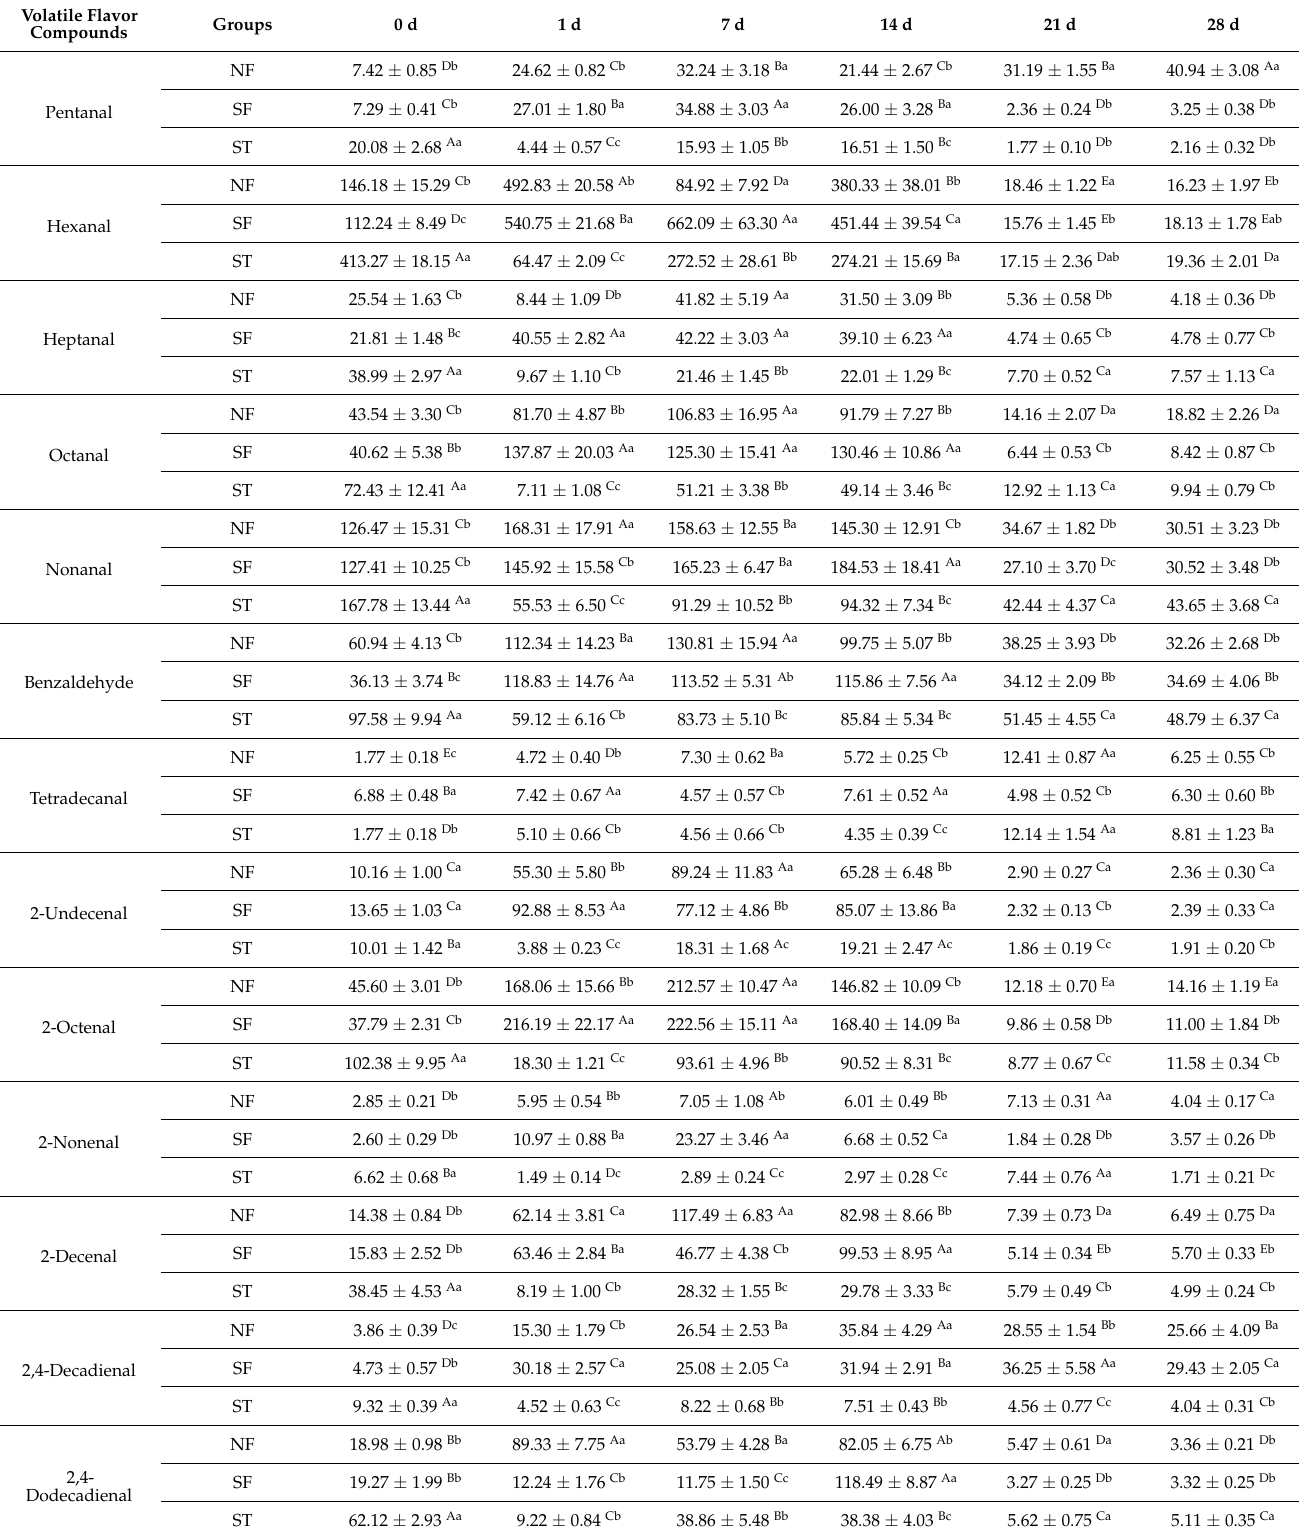
Table 2. Effects of three processing methods on volatile flavor compounds in lamb liver paste ( µ